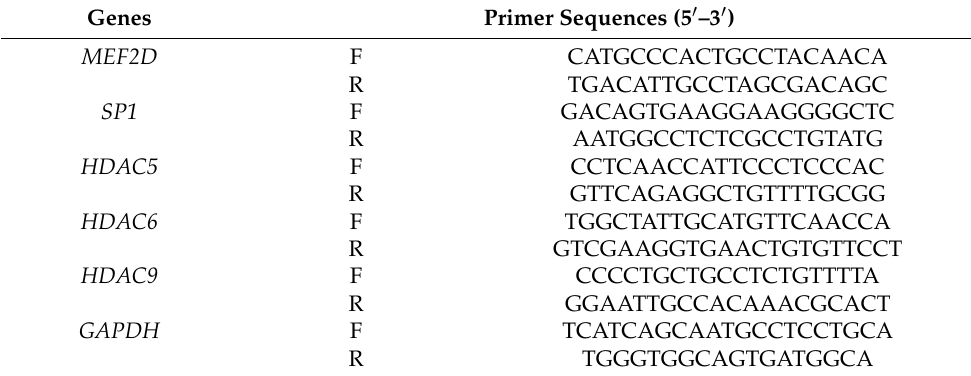
Table 1. List of primers used in this study.